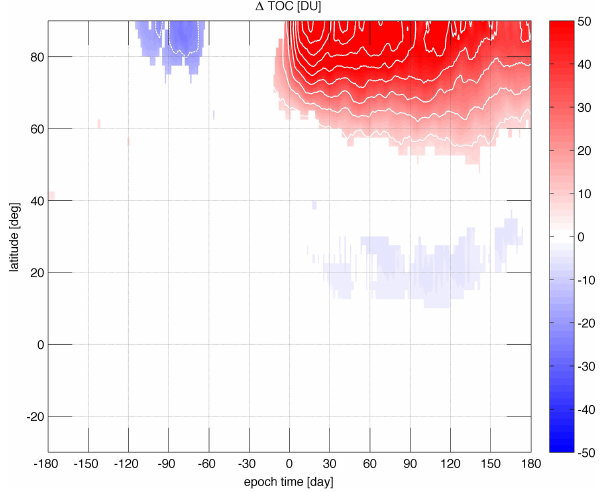
Figure 2. Composite of the anomaly (cid:49) TOC as function of epoch time (0 is the central date of SSW) and geographic latitude. Values are only shown if they exceed the 2 σ level where σ is the error of the mean of the SSW ensemble. After the SSW, increased (cid:49) TOC values of up to 90DU occur in the polar region. A negative anomaly of about − 20DU is present in polar ozone 90 days before the SSW. The white contour lines have a spacing of 10DU. The composite is based on 20 major